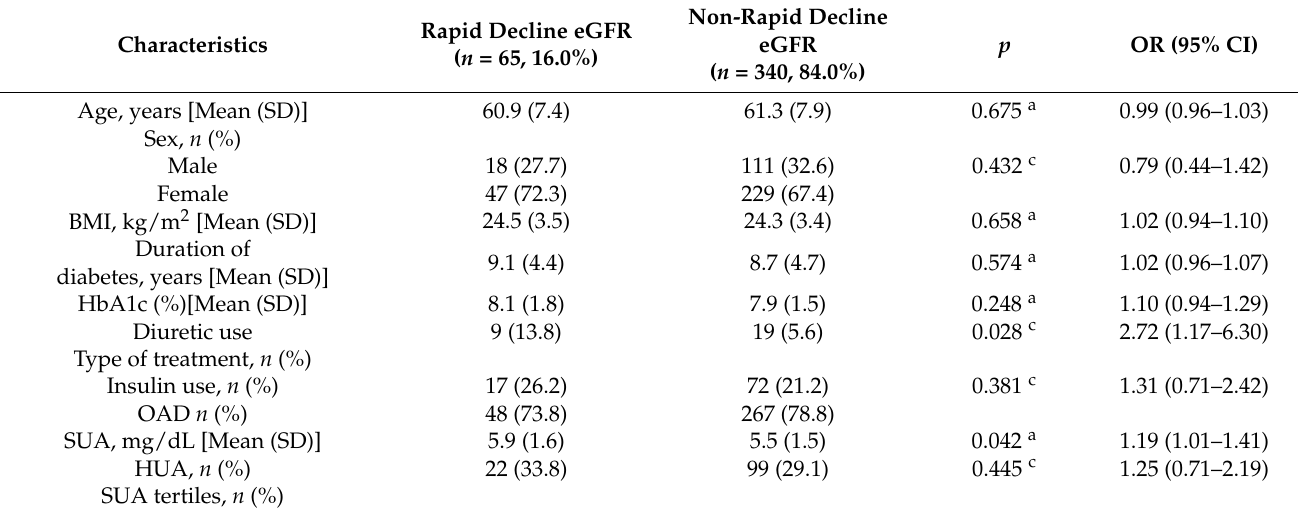
Table 2. Participant baseline characteristics for each of the decline